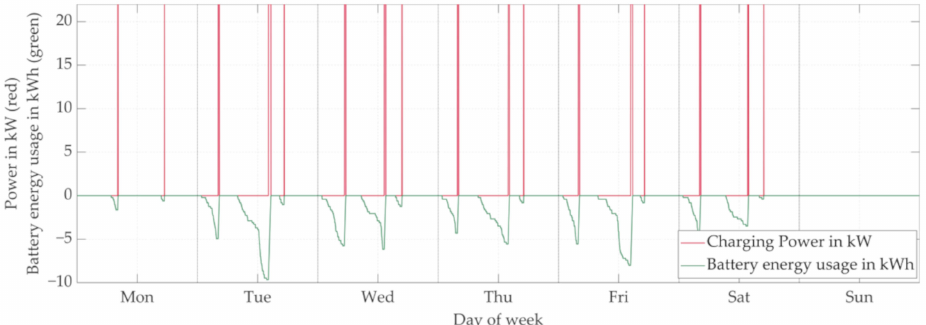
Figure 7. One-week profile of vehicle energy demand and the resulting charging profile while